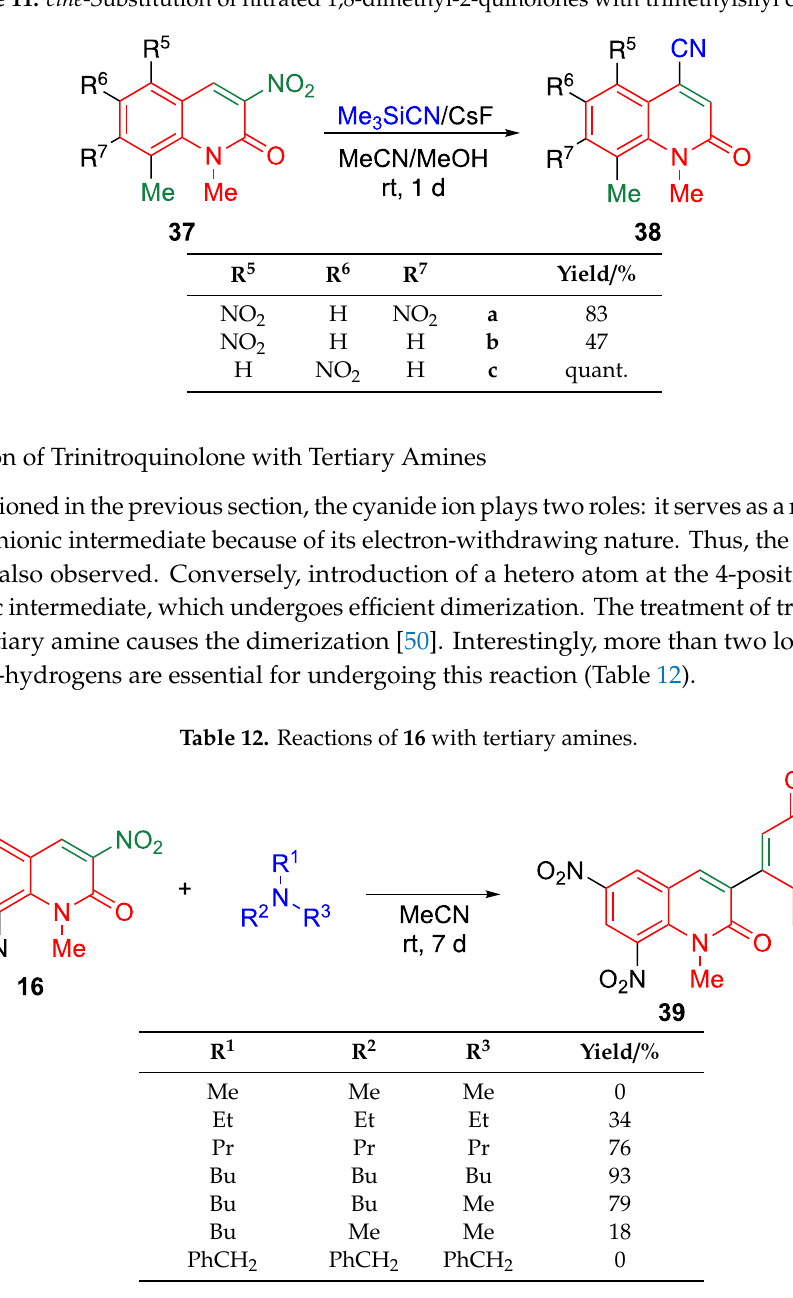
Table 11. cine -Substitution of nitrated 1,8-dimethyl-2-quinolones with trimethylsilyl cyanide.